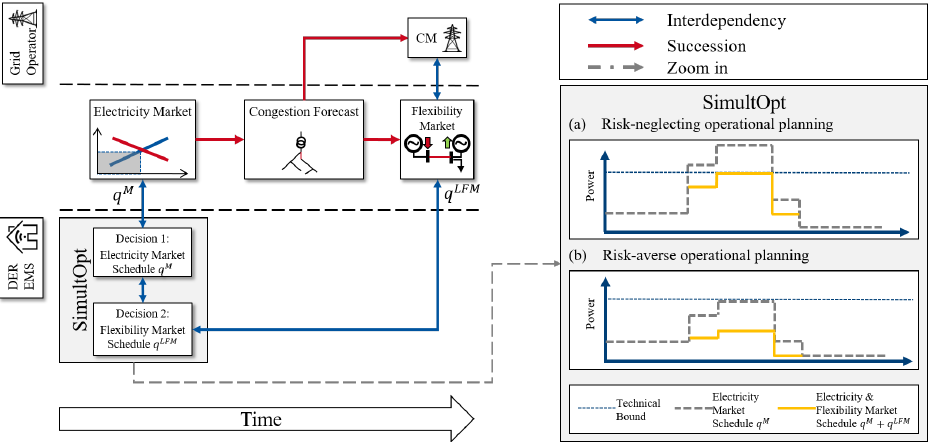
Figure 4. Anticipatory operational planning in electricity markets and LFMs with potential schedules of (a) risk-neglecting and (b) risk-averse operational